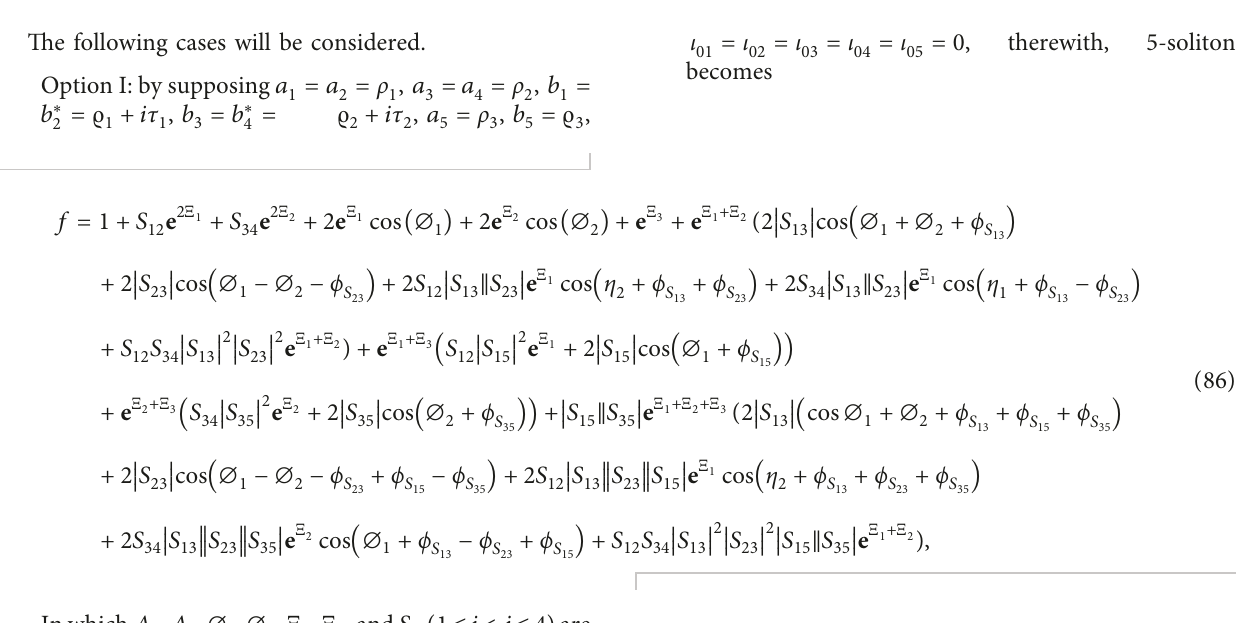
Figure 21: Plots of equation (83) by utilizing ϕ f 1. (b) f 2. (c) f 3. (d) f 4. (e) f 5. (f) f